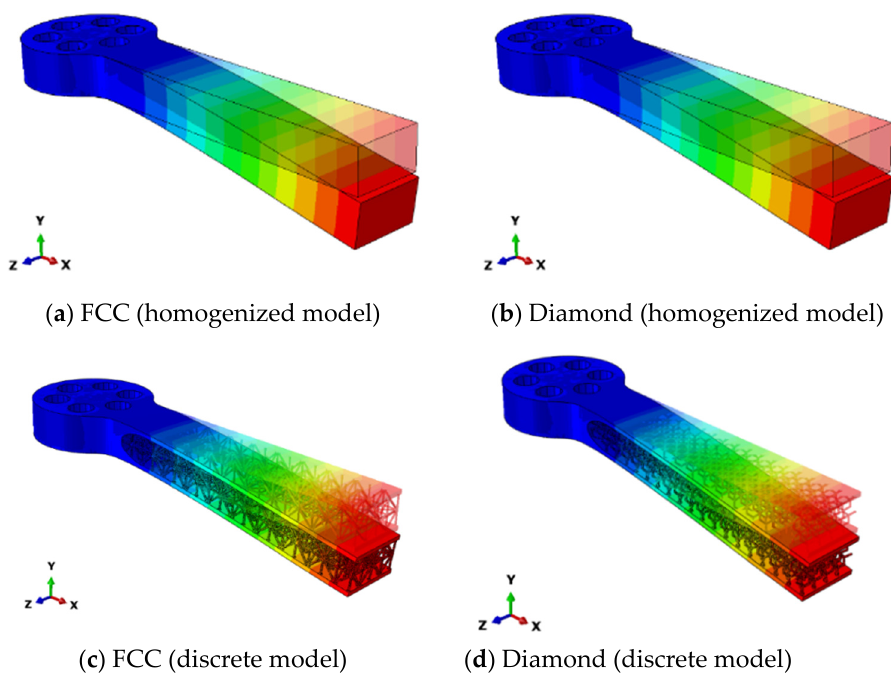
Figure 4. First shape mode of ( a , b ) the homogenized models and ( c , d ) the discrete models.